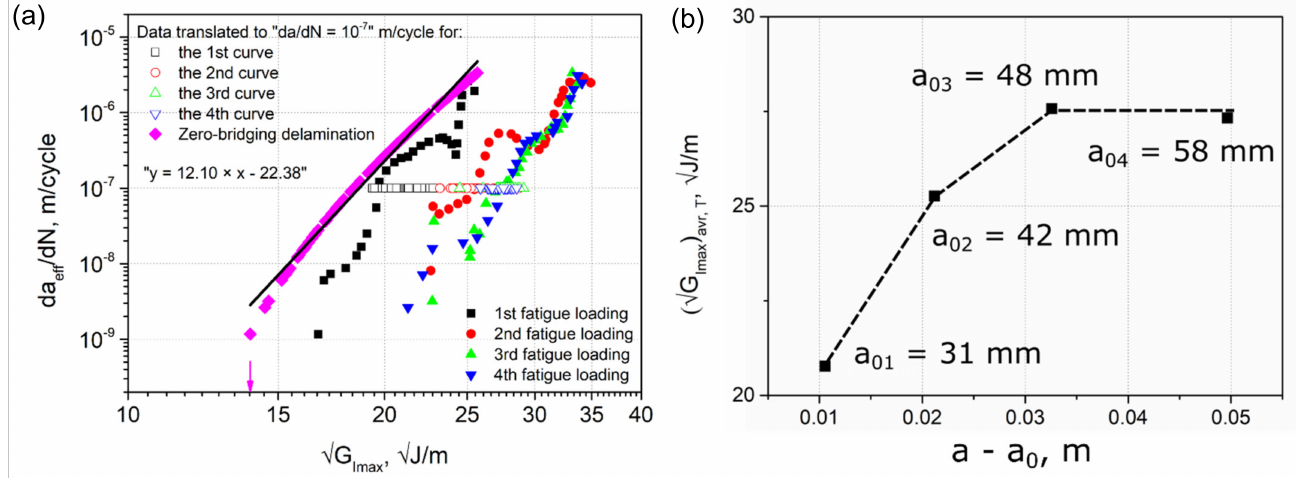
Figure 13. The “zero-fiber bridging” analysis: ( a ) The data translated to an arbitrary value of da / dN = 10 − 7 m/cycle for every curve (unfilled symbols) and the final zero-bridging curve (pink rhombs); ( b ) the average values of the translated data versus the crack